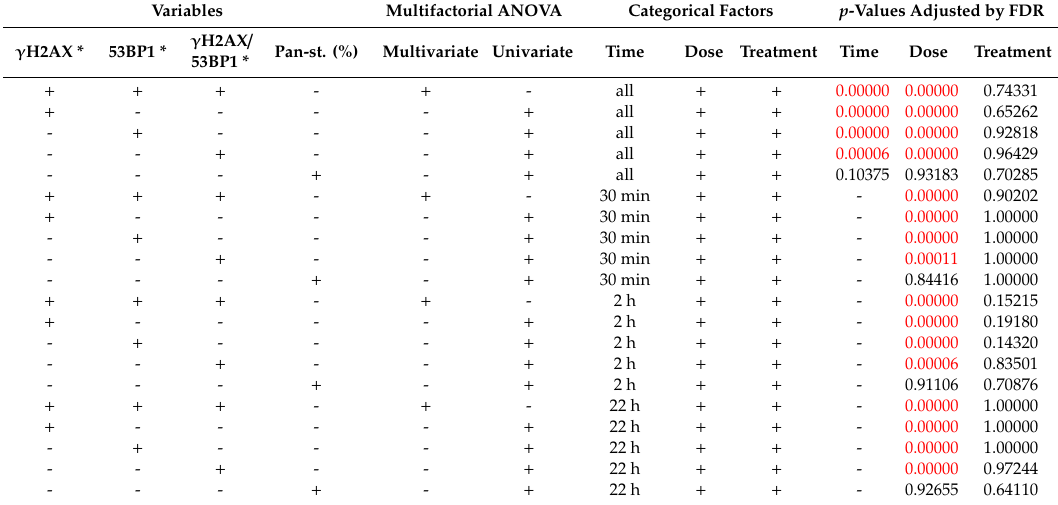
Table 1. Statistical testing dependence of the DNA repair foci and γ H2AX pan-staining on dose, post-irradiation time, and treatment with the DNaseI Variables Multifactorial ANOVA Categorical Factors p -Values Adjusted by